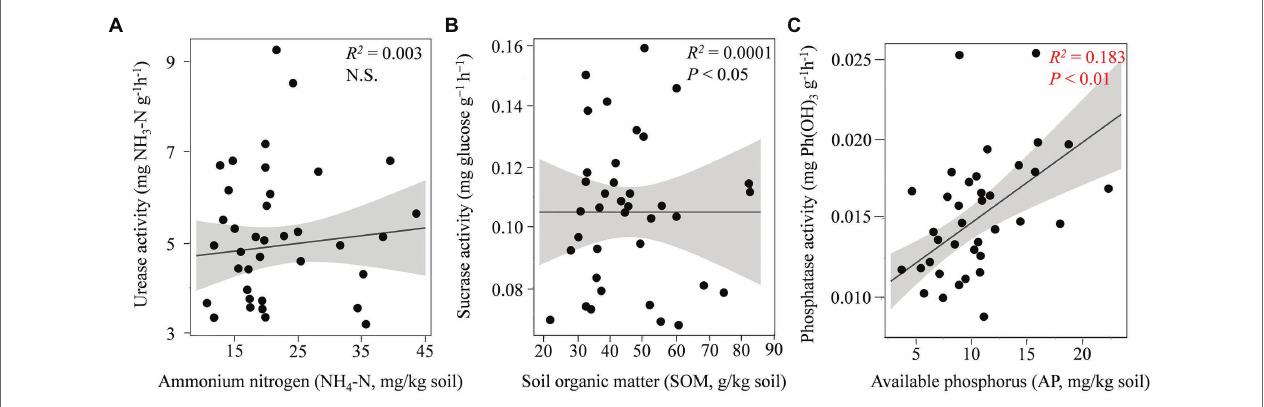
FIGURE 1 | Relationship between edaphic properties and soil enzymatic activities. The relationships between ammonium-nitrogen (NH 4 -N) and urease (A) , soil organic matter (SOM) and sucrase (B) , and available phosphorus (AP) and phosphatase (C) are shown by the linear regression analysis. The red color indicates a significant